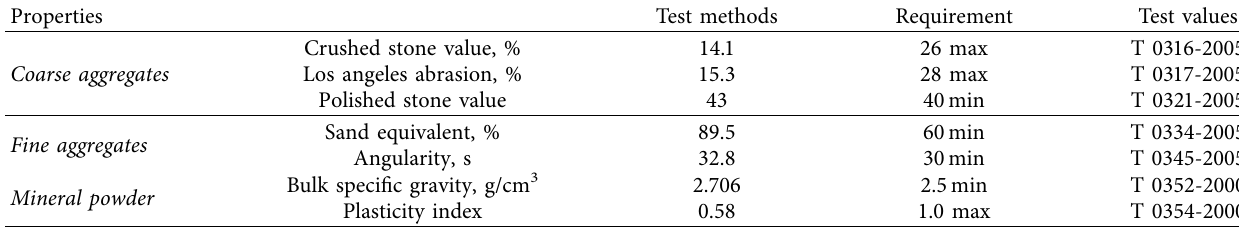
Table 2: Properties of the mineral aggregates.